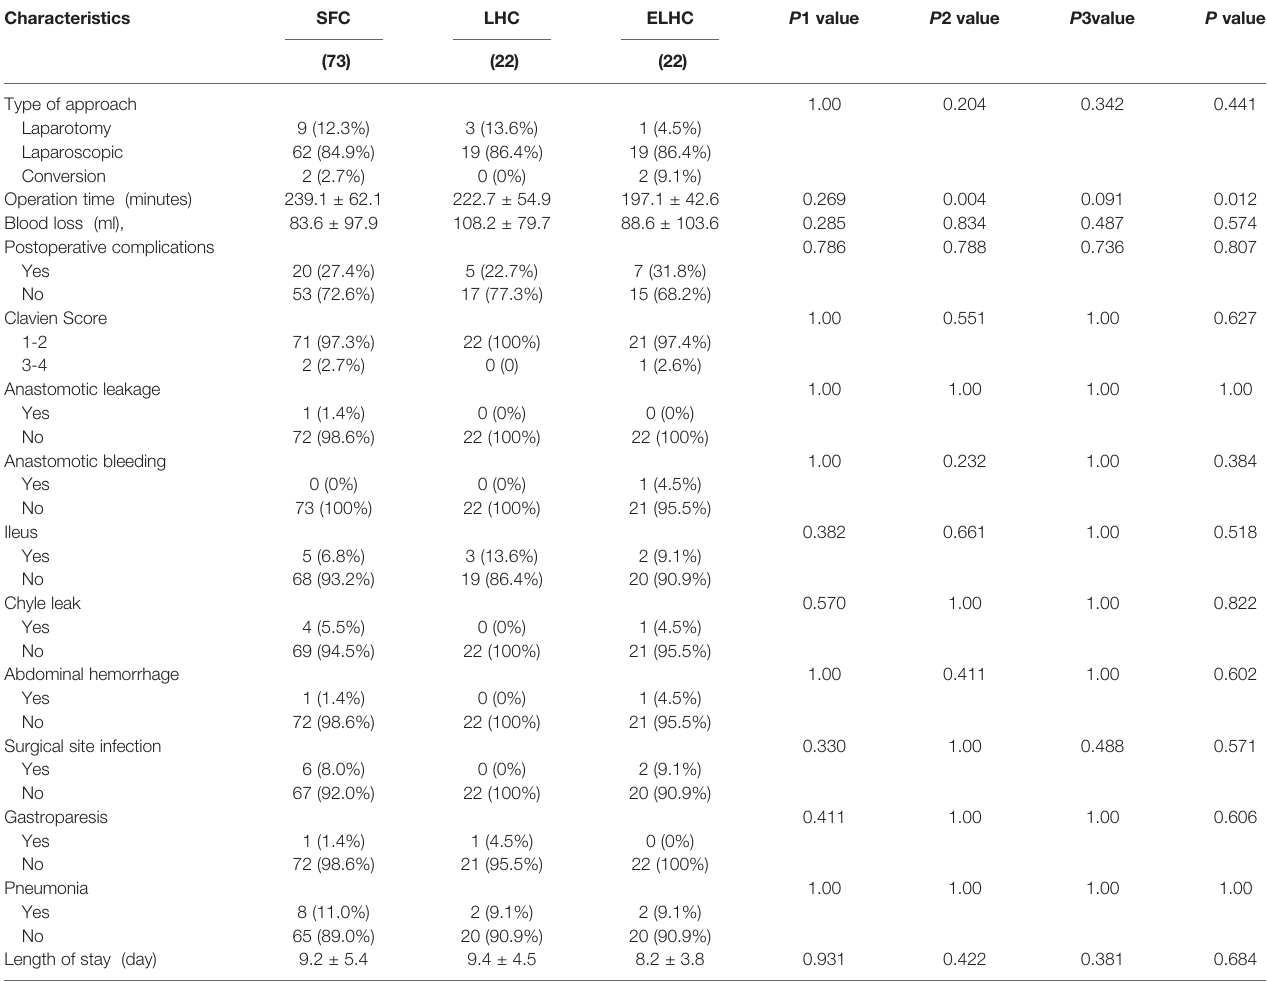
TABLE 2 | Postoperative outcomes of patients treated by SFC, LHC or ELHC for splenic fl exure cancer. Characteristics